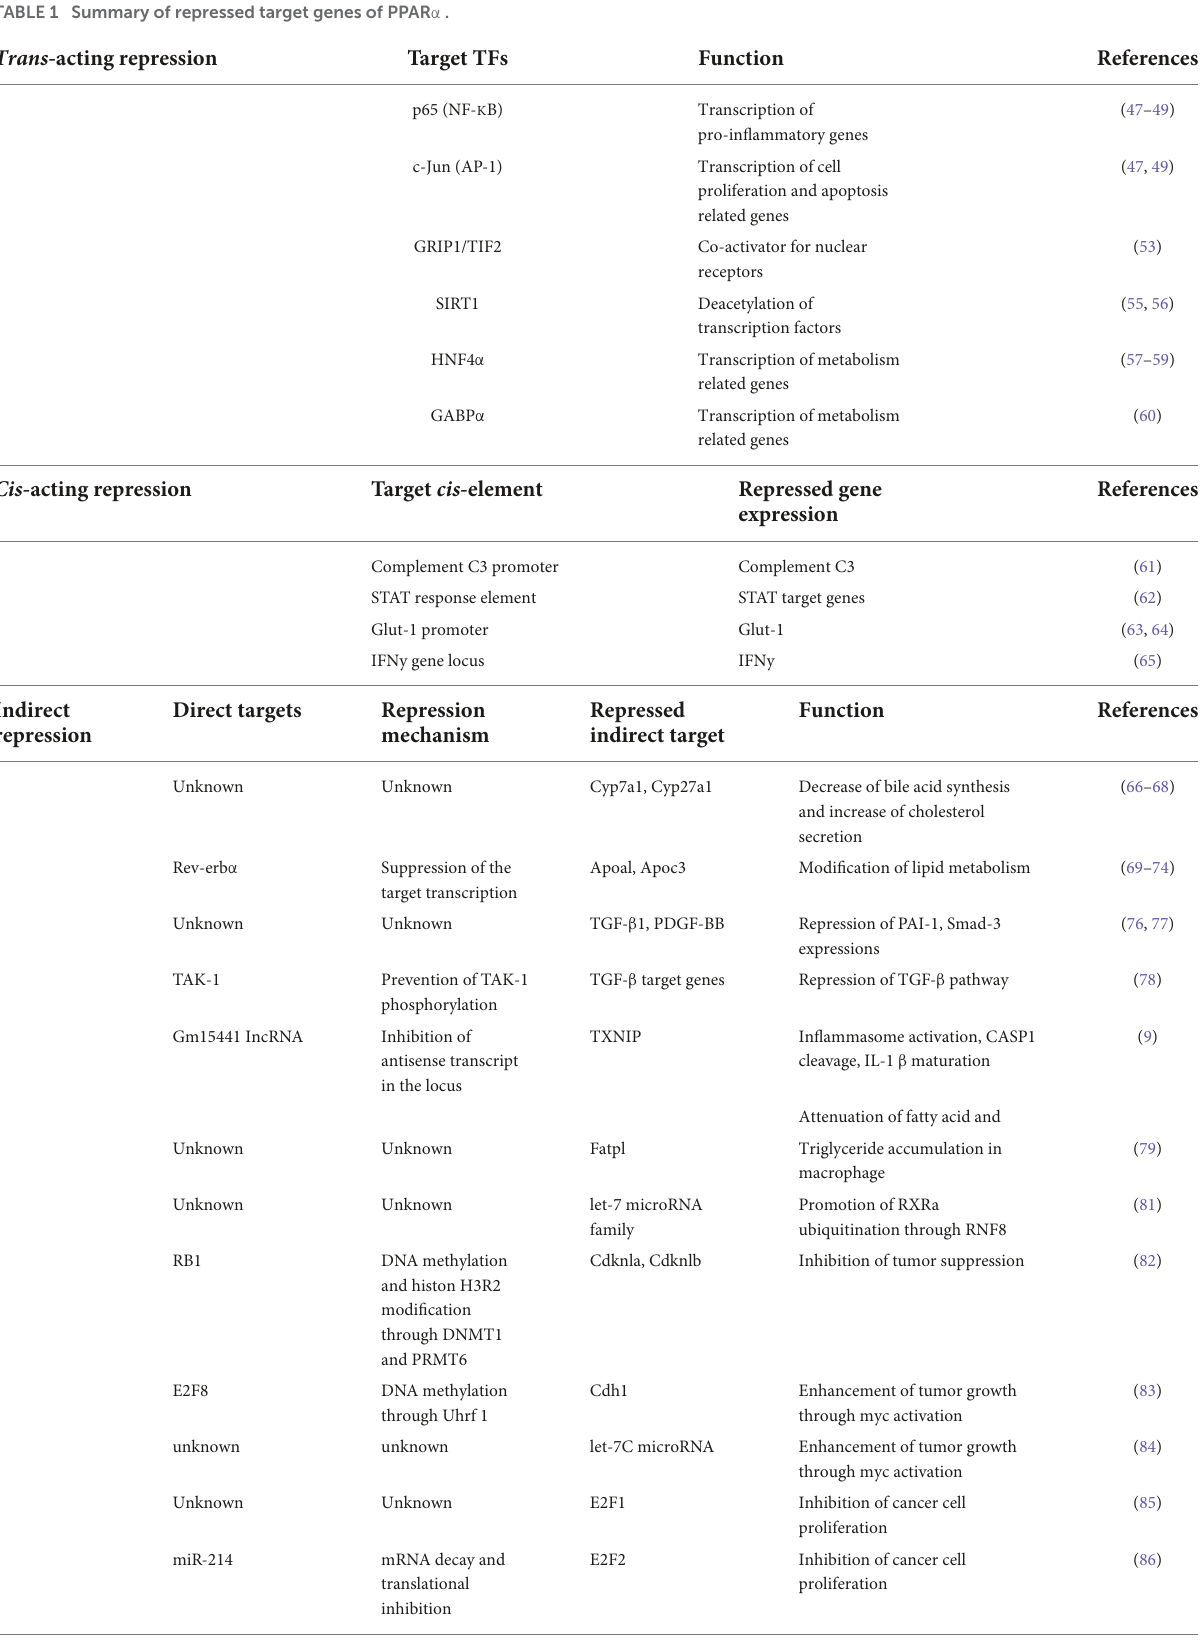
TABLE 1 Summary of repressed target genes of PPAR α . Trans -acting